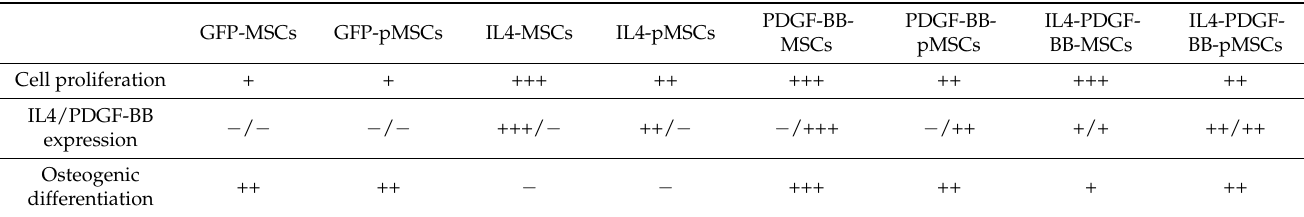
Table 2. The summary of the